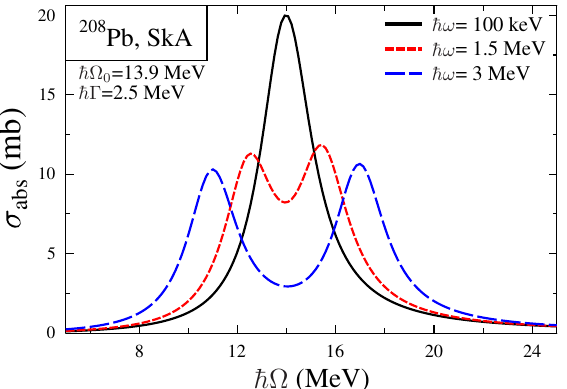
Figure 1. Photon absorption cross-section of 208 Pb in a laser field for three different frequencies: ¯ h ω = 100 keV (full line), 1.5 MeV (short dashes) and 3 MeV (long dashes). Calculations are made for the SkM parametrization of H Sky and the spreading width Γ = 2.5